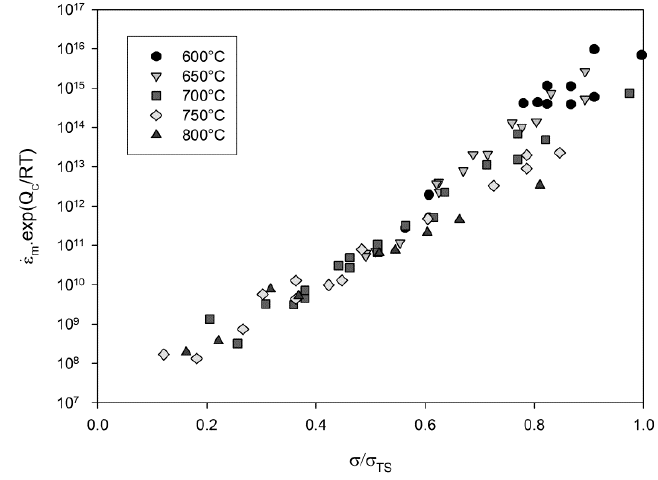
Figure 6. The relationship between σ / σ TS and ( ε(cid:4662) m ·exp(Q c /RT)) in Waspaloy.